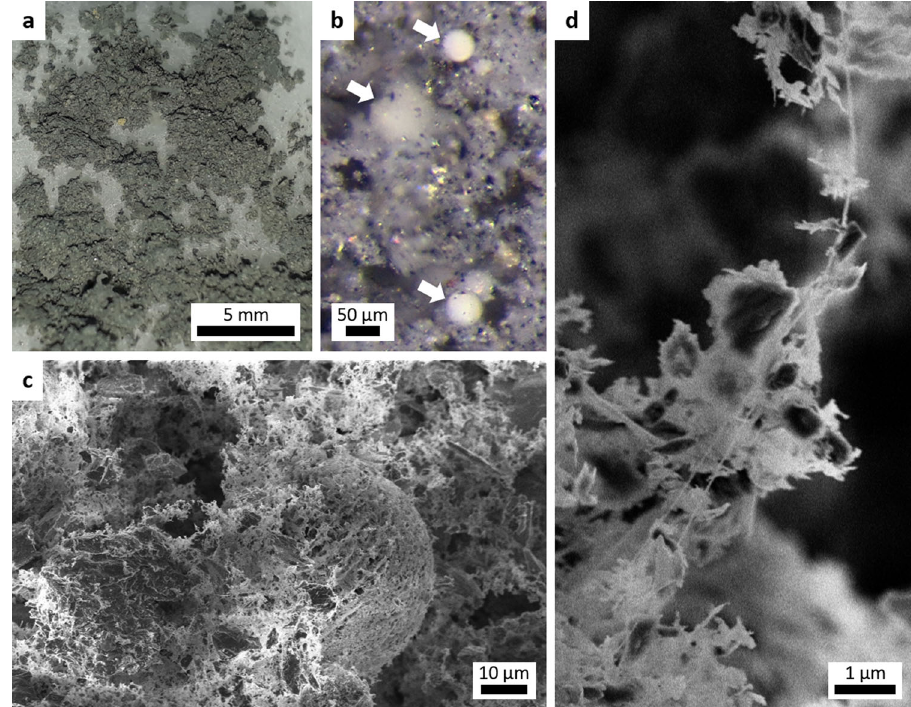
Fig. 5 Micrographs of the Ceres analogue sublimation residue. a Close-up photo of the residue on cotton wool. b OM image showing pale spheres (arrows) embedded in a grey matrix. c SEM image revealing the high porosity of the residue. d SEM close-up of a fi lament.